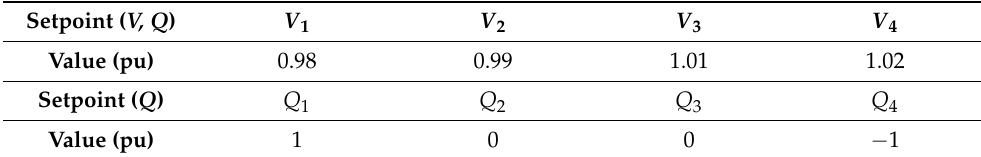
Figure 5. IEEE 30-bus test system [33]. Table 1. Volt/Var control setpoint.